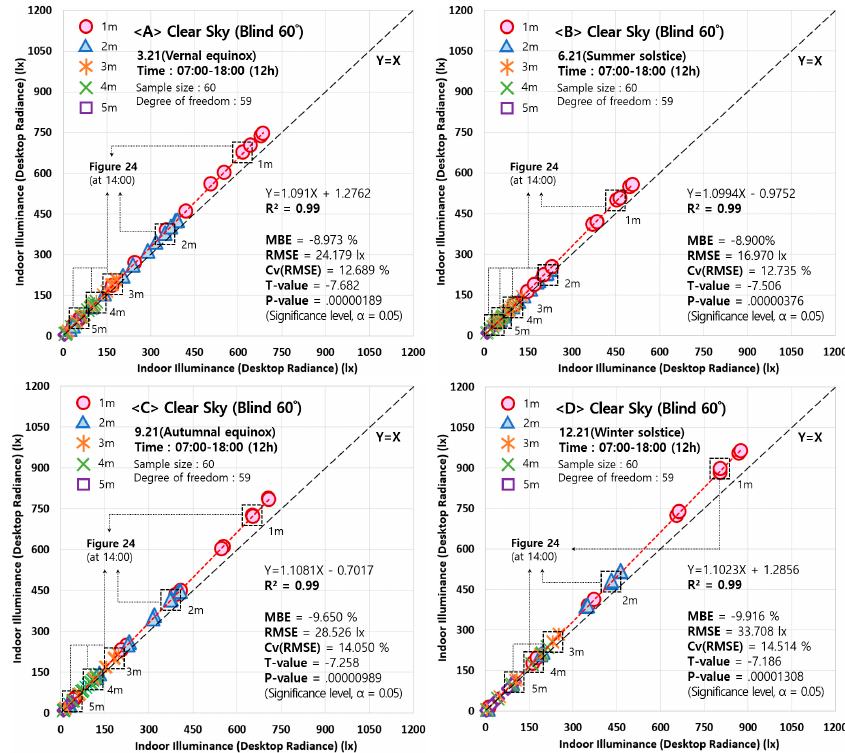
Figure 25. Comparison of indoor illuminance between the modified equation and Desktop Radiance simulation when installing external venetian blind 60° ( A ) 3.21 ( B ) 6.21 ( C ) 9.21 ( D ) 12.21 (07:00–18:00).